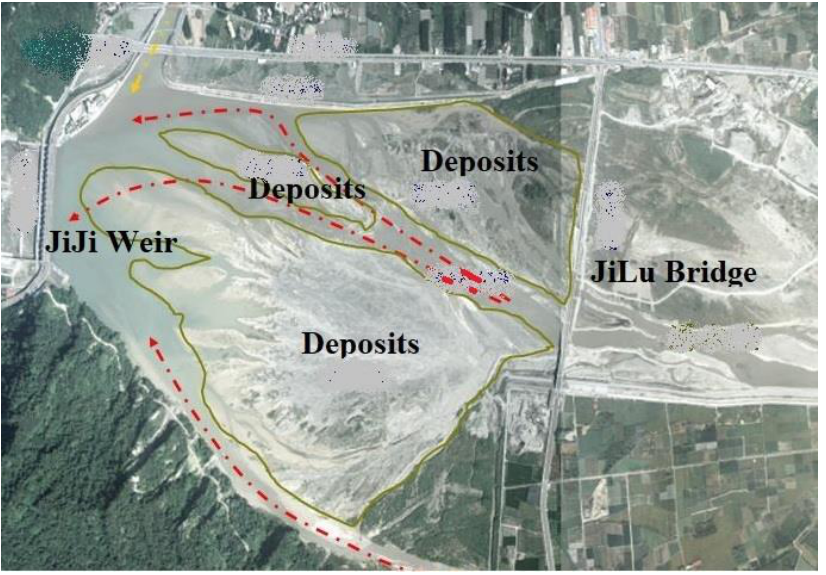
Figure 11. JiJi Reservoir.